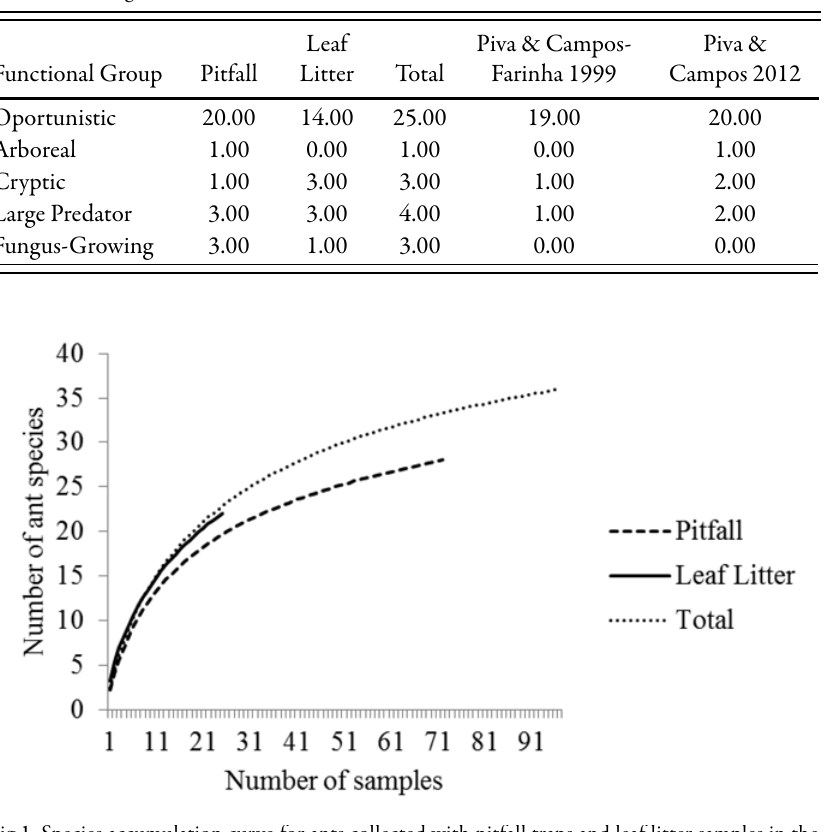
Fig.1. Species accumulation curve for ants collected with pitfall traps and leaf litter samples in the park of Instituto Biológico, São Paulo,